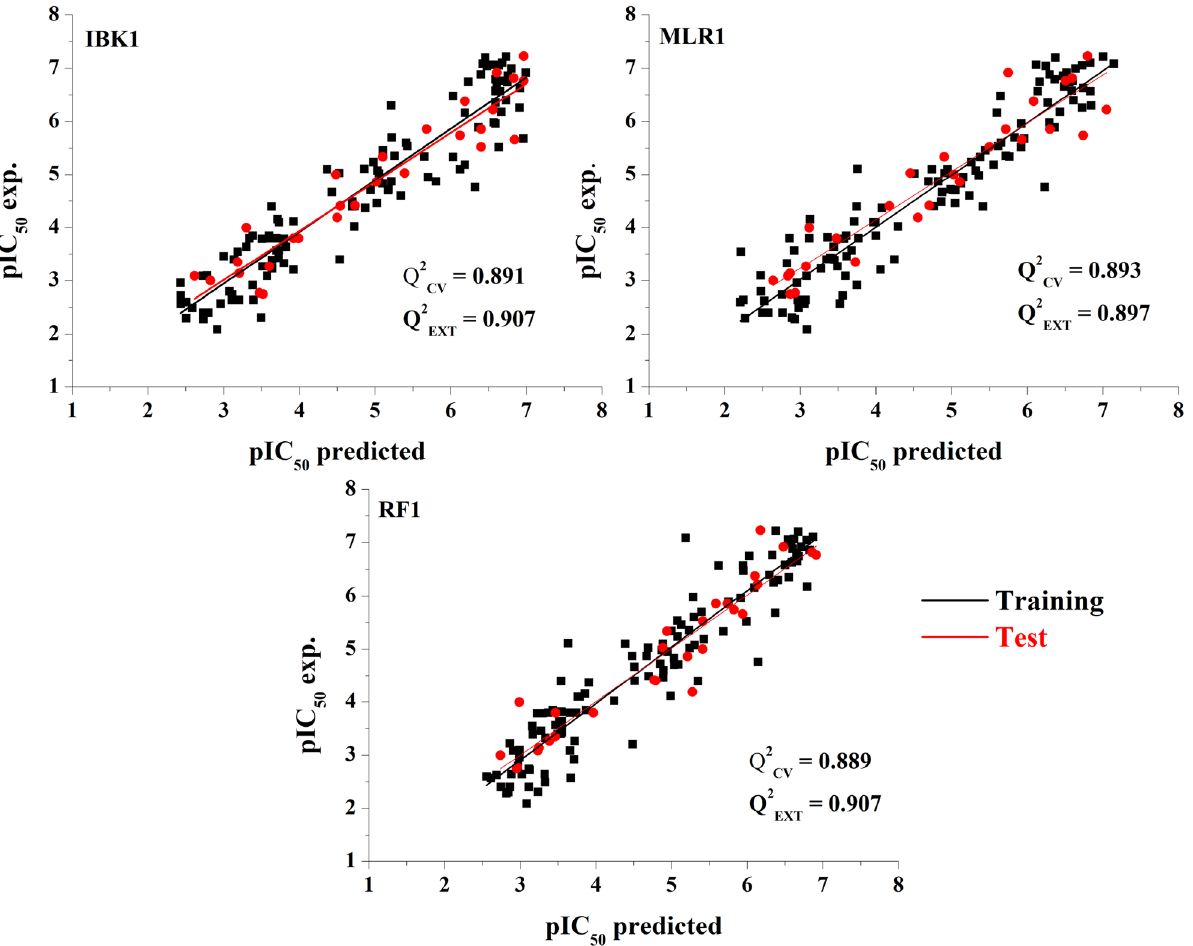
Figure 3. Experimental versus predicted pIC 50 values obtained by models MLR1, RF1 and